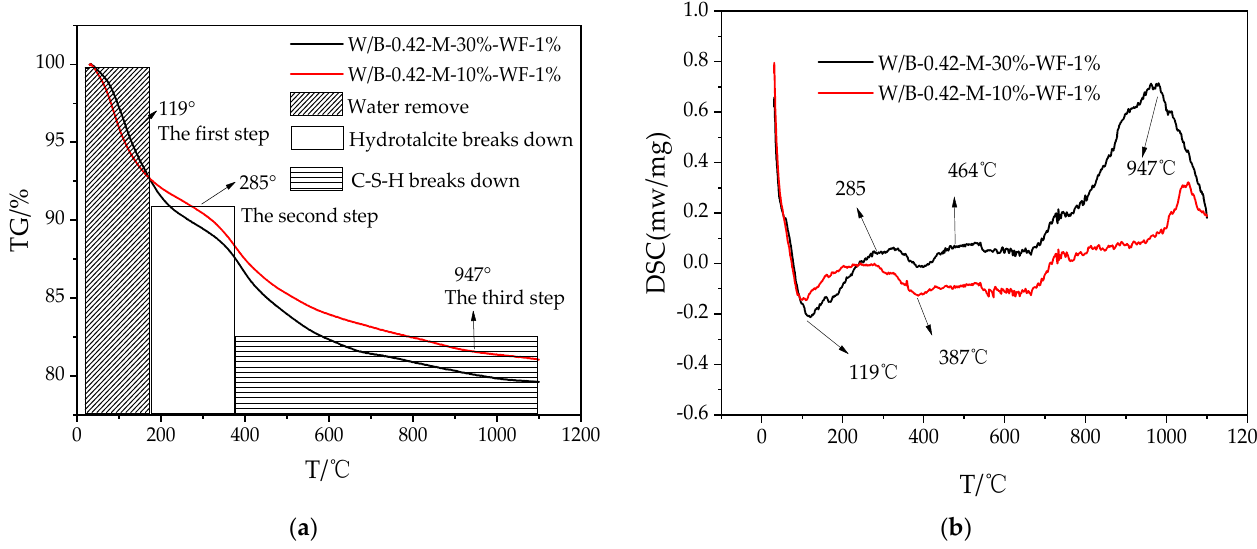
Figure 8. Thermogravimetric analysis curves of specimens. ( a ) TG curves. ( b ) DSC curves.